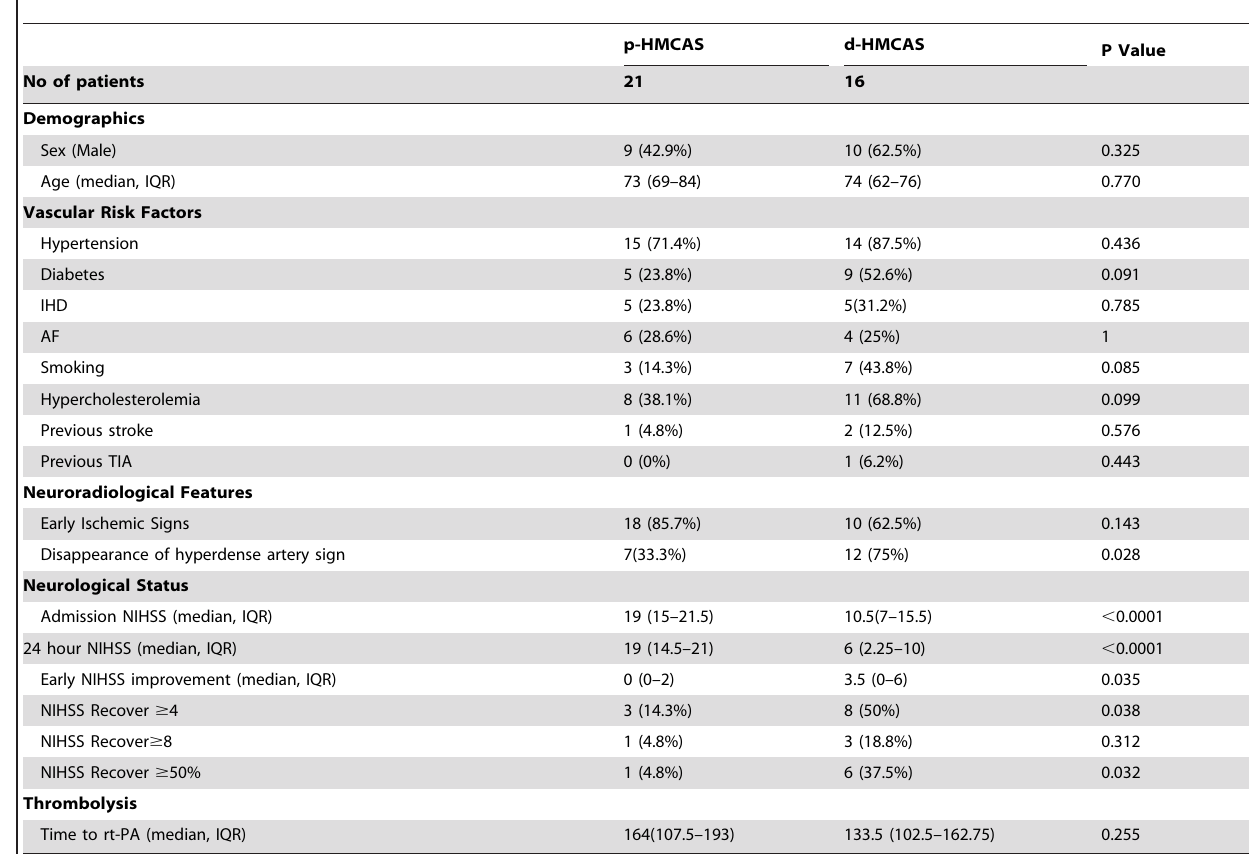
Table 2. Baseline data and response to rt-PA between patients with proximal hyperdense artery sign and distal hyperdense artery